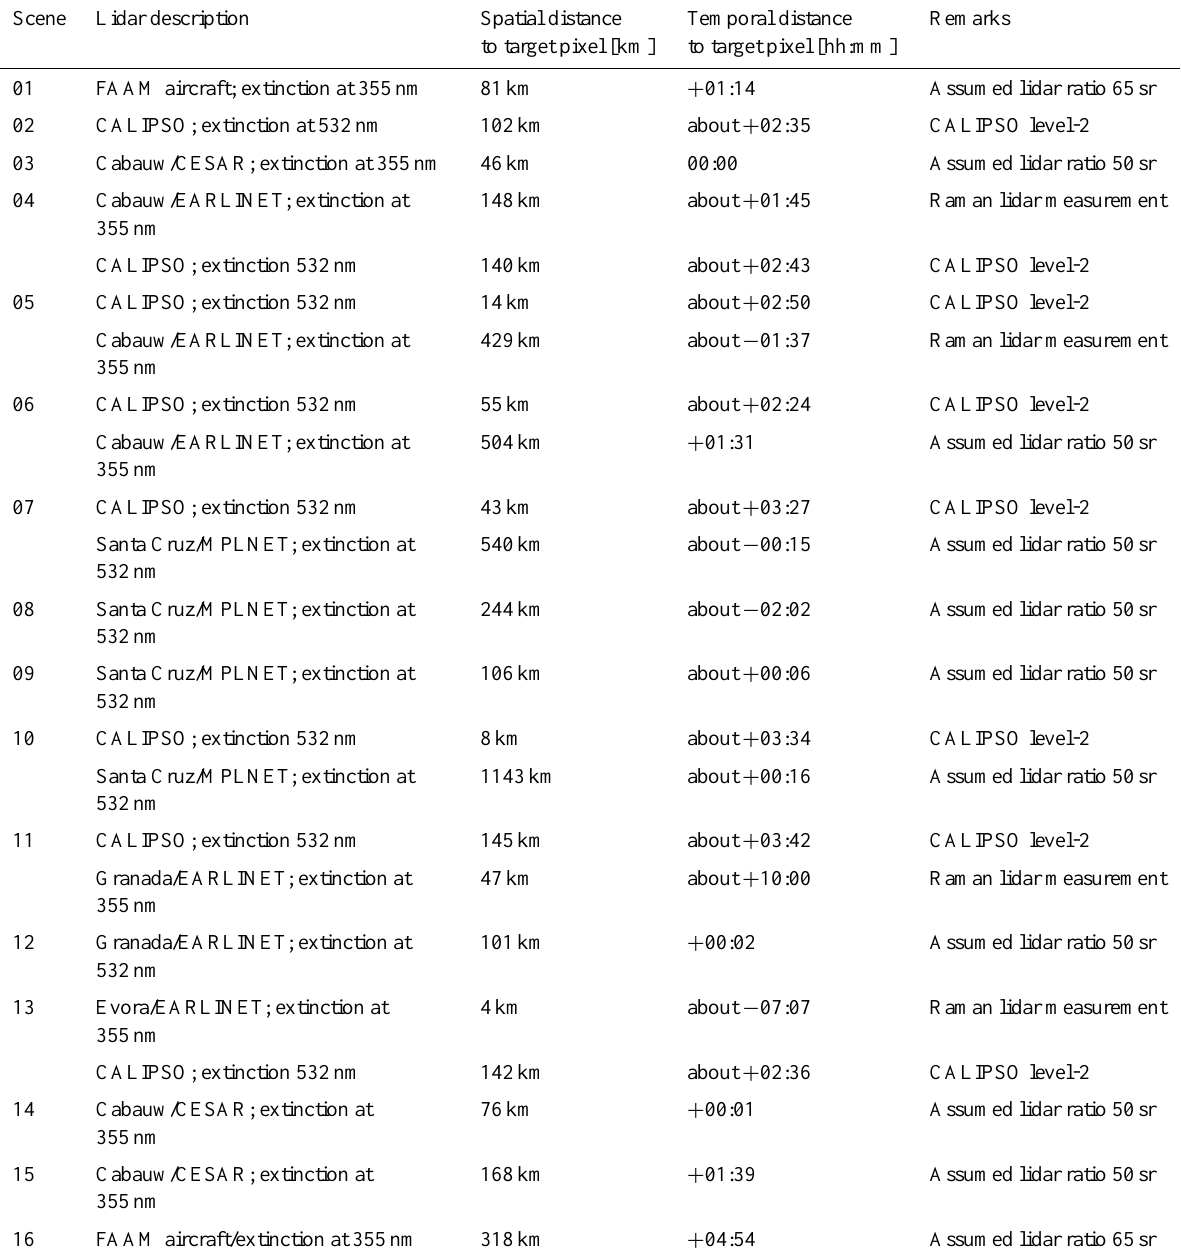
Table 5. Description of the lidar measurements that are used in the comparison with retrieved aerosol heights for GOME-2A target pixels. Spatial distance is the distance between the centre of the GOME-2A target pixel and the location of the lidar measurement. Recall that GOME-2A pixels are usually 80km by 40km. Temporal distance is defined as the time of the lidar measurement minus the observation time for the GOME-2A target pixel. Reported lidar extinction profiles are not instantaneous but averaged over a certain time window. Averaging times vary with lidar systems and atmospheric